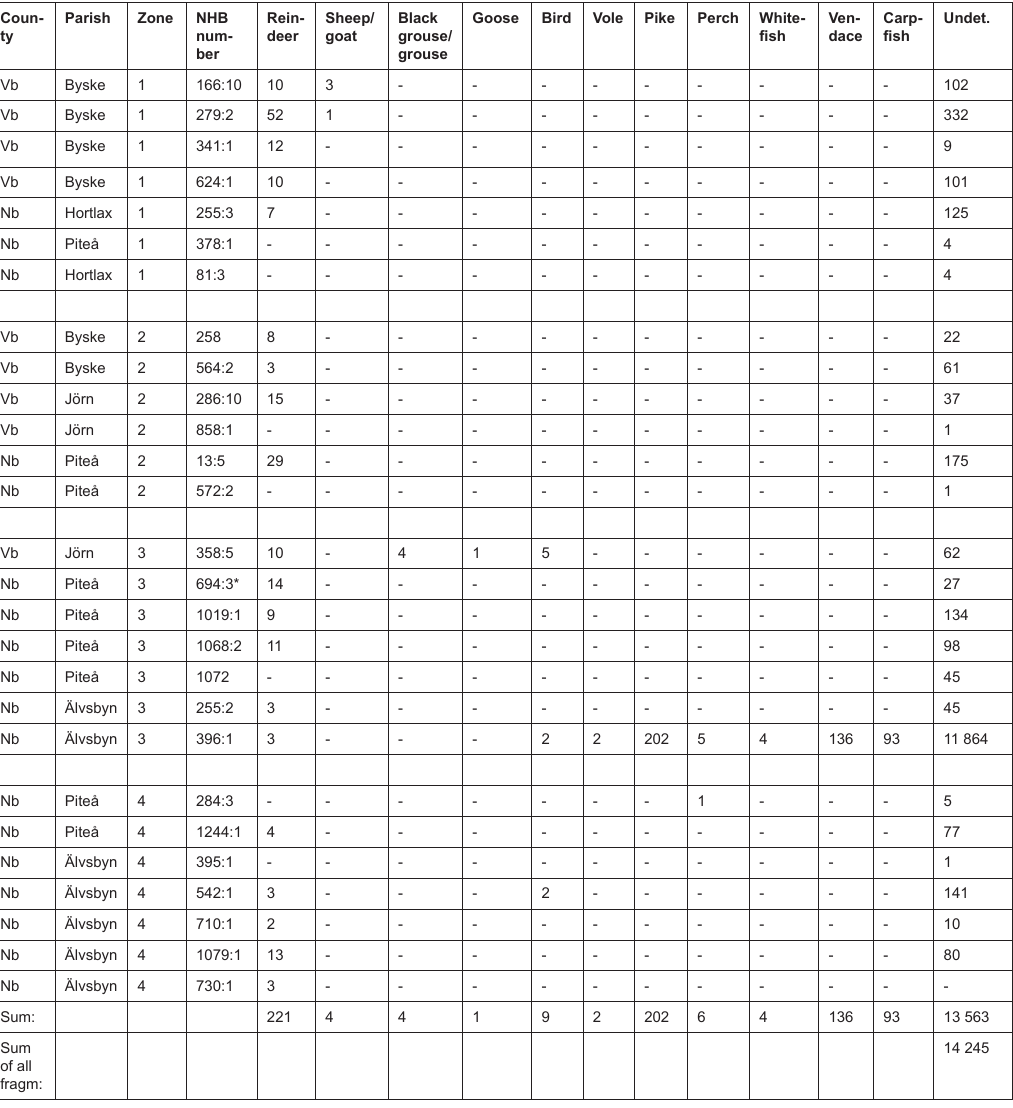
Goose Bird Vole Pike Perch White-